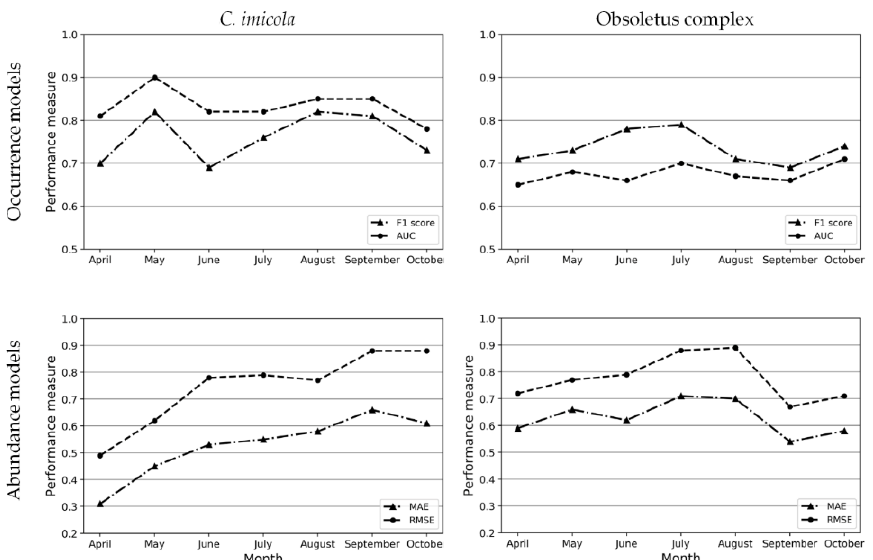
Figure 4. Performance of Culicoides spp. occurrence and abundance models. For occurrence models, the F1 score and area under the receiver operating characteristic curve (AUC) are shown, while for abundance models mean absolute error (MAE) and root mean square error (RMSE) are shown.